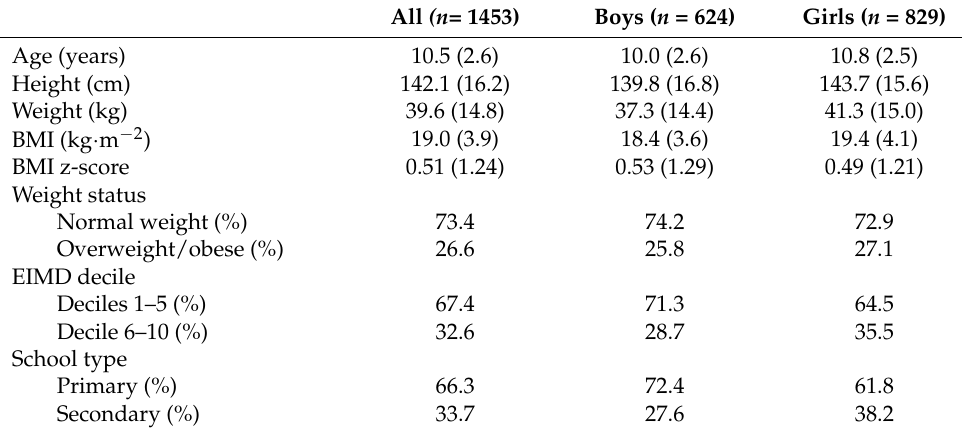
Table 1. Participants’ descriptive characteristics (M (SD) or